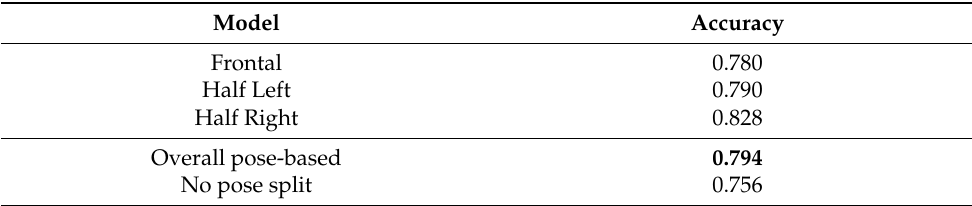
Table 1. Validation set accuracy comparison of the pose-based and non-pose based models. Overall represents the accuracy score obtained from concatenating the predictions from pose-based models.